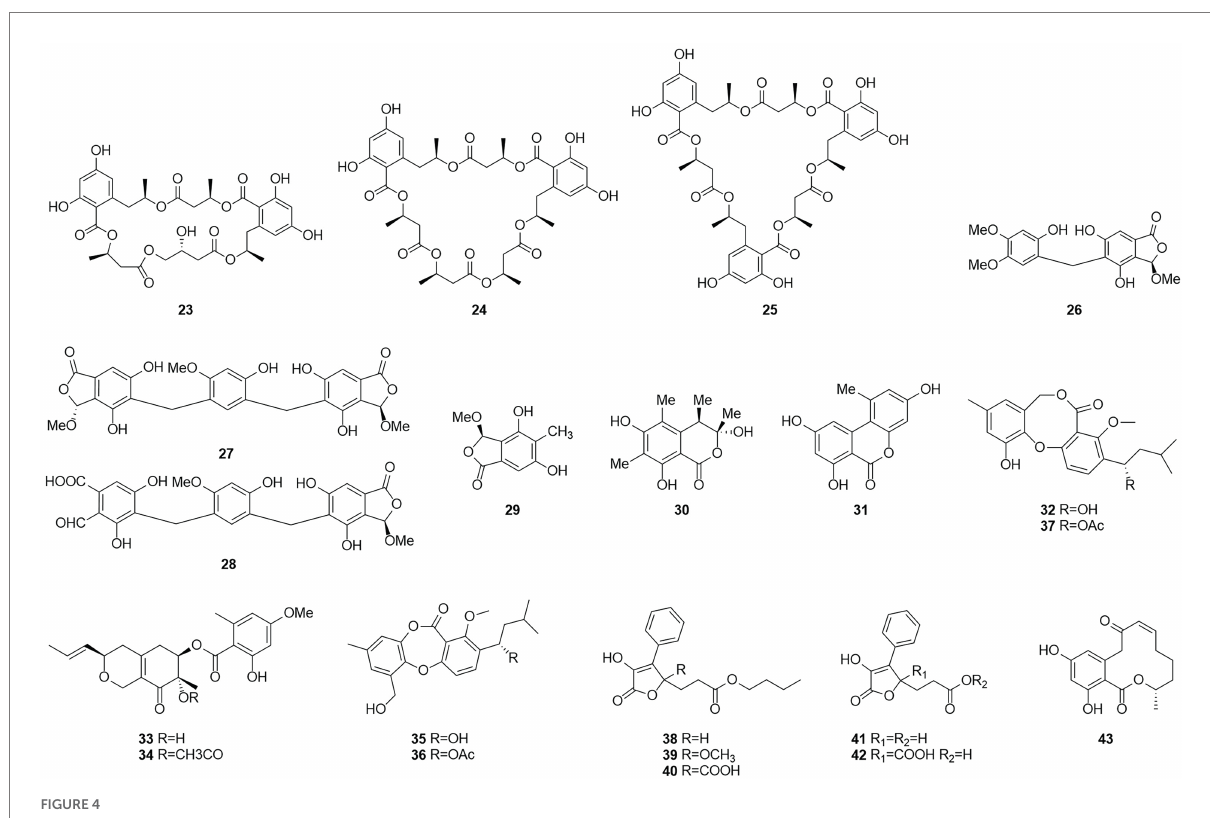
FIGURE 4 Chemical structures of compounds 23–43 .